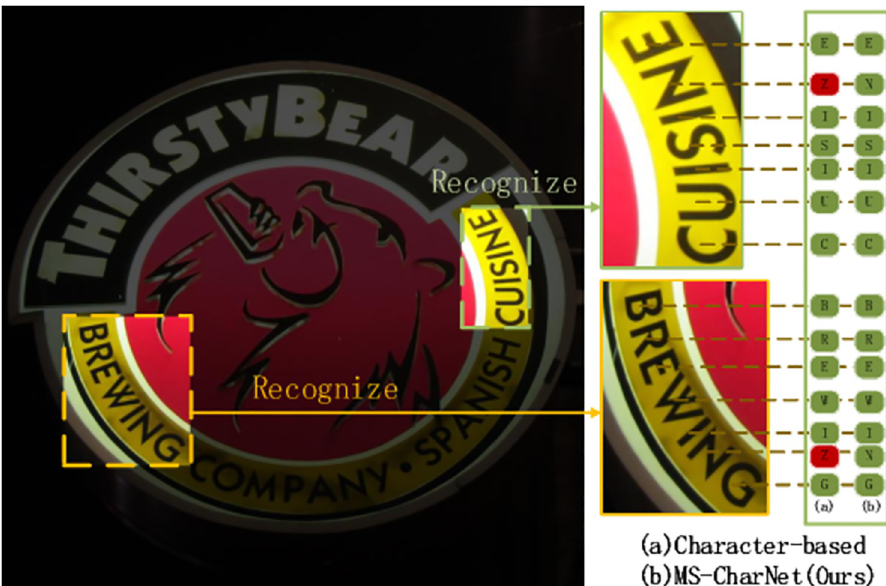
Fig 1. Illustrations of different Char recognition method. When the rotation angles of characters in natural scenes is particularly large, some characters will be extremely similar(such as ‘N’ and ‘Z’). Ordinary character detection methods (a) can hardly cope with this situation, resulting in false detection of characters, which can be well solved by our (b) MS-CharNet’s fusing the character features of each angle domain. Reprinted from [19] under a CC BY license, with permission from IJDAR, original copyright